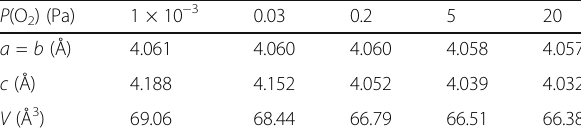
Table 1 Results of in-plane ( a = b ) and out-of-plane ( c ) lattice parameters and cell volumes ( V ) of the SSNO thin